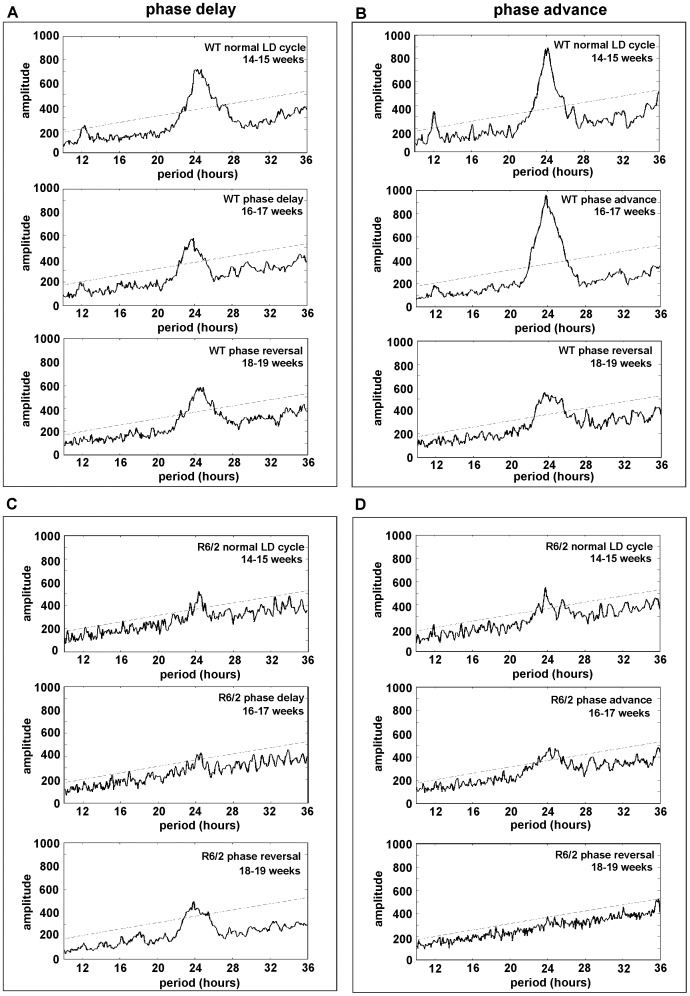
Periodograms from the second week of each phase-shift in the shift/reversal experiment from representative WT and R6/2 mice.Panel A shows a WT mouse undergoing phase-delay and reversal, Panel C an R6/2 mouse under the same conditions. Panel B shows a WT mouse undergoing phase-advance and reversal, Panel D an R6/2 mouse under the same conditions. The amplitude decreased with age in R6/2 mice, but was more strongly maintained under conditions of phase-delay with phase-advance as the reversal, than under phase-advance with phase-delay as the reversal. The dotted line in the periodograms represents significance at p<0.001.